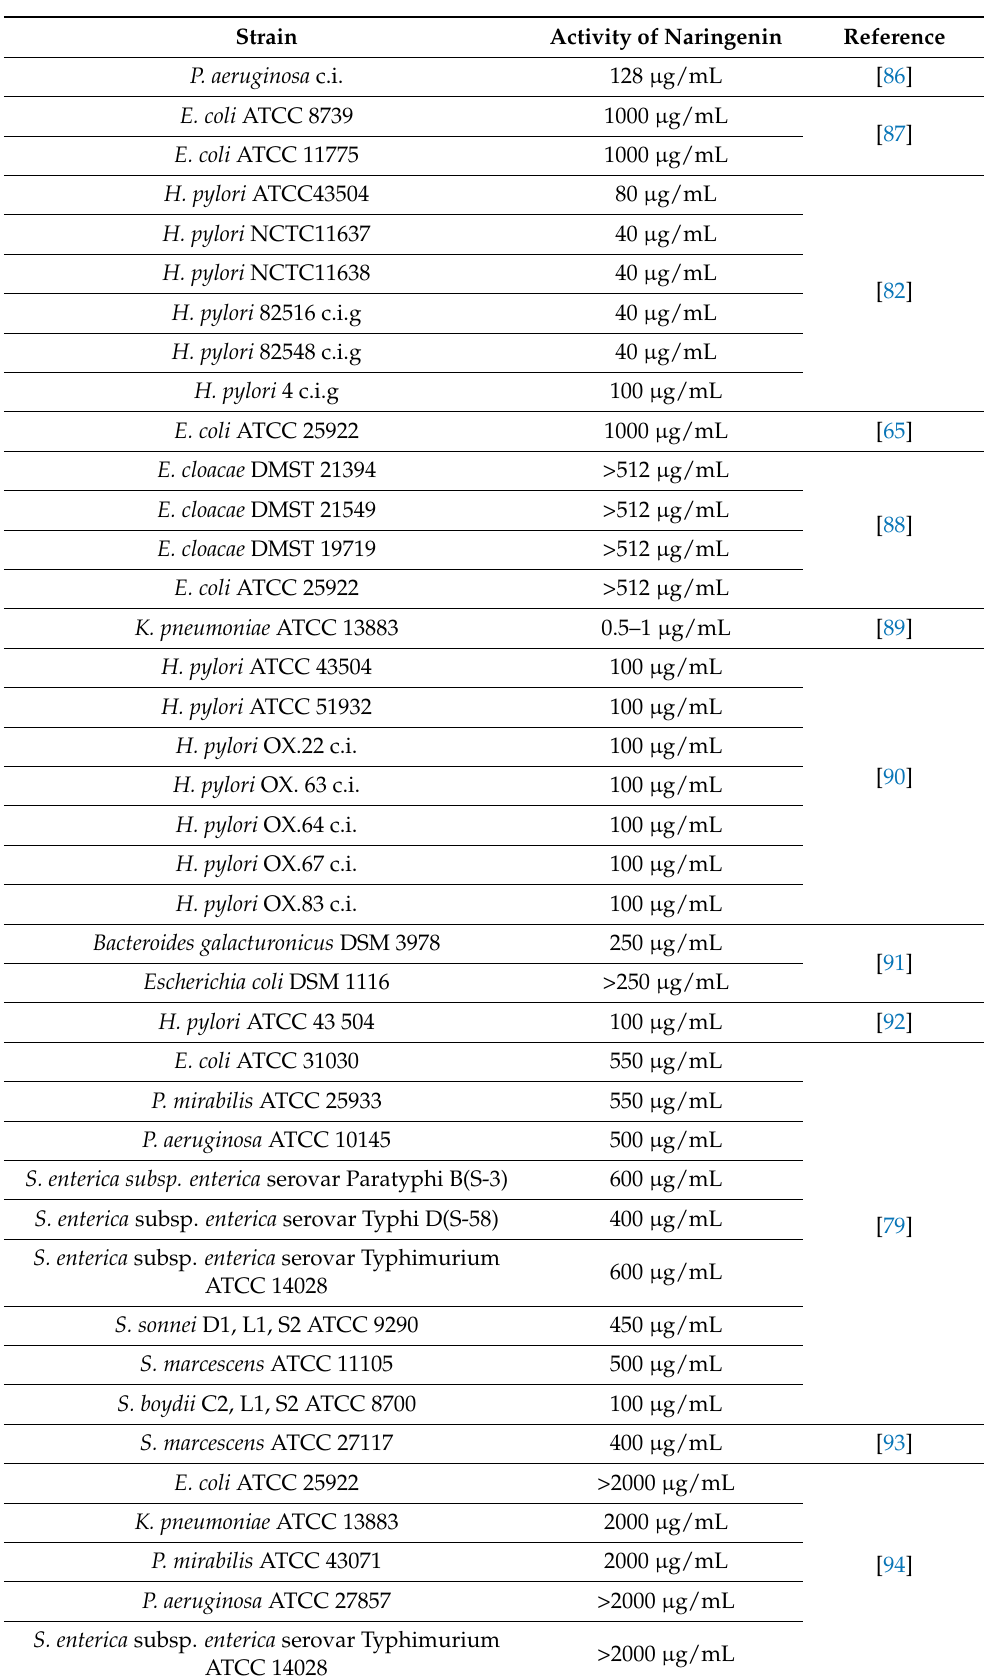
Table 1. In vitro activity of naringenin and naringin against Gram-negative